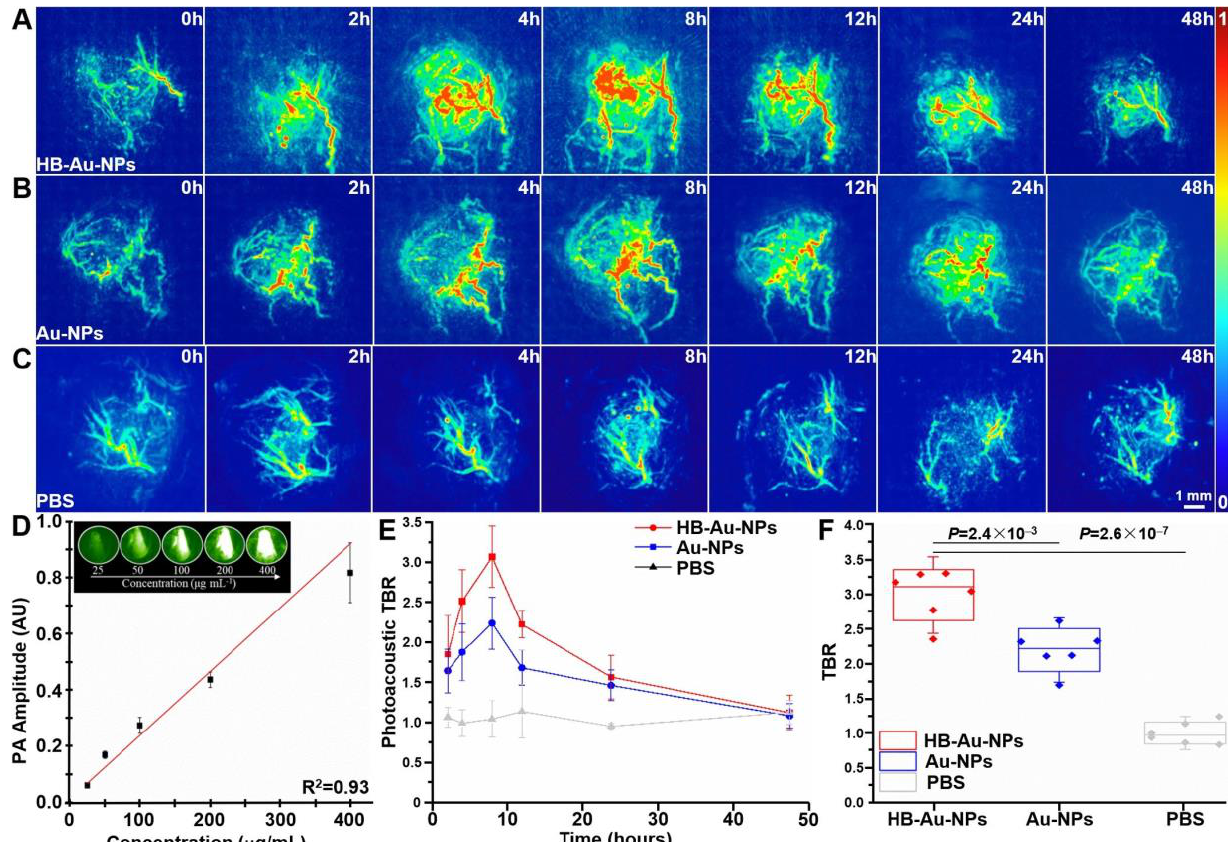
Figure 4. Photoacoustic tomography. In vivo images of human xenograft tumors implanted in mice are shown between 0–48 h post-injection of ( A ) HB-Au-NPs, ( B ) Au-NPs, and ( C ) PBS. ( D ) The in vitro photoacoustic intensity increases linearly with concentration of HB-Au-NPs, R 2 = 0.93. Inset: photoacoustic images are shown of HB-Au-NPs in vials at different concentrations (25, 50, 100, 200, and 400 µ g/mL). ( E ) Quantified intensities from the tumors show a peak T/B ratio of 3.08 ± 0.37 and 2.27 ± 0.31 at 8 h post-injection for HB-Au-NPs and Au-NPs, respectively. ( F ) The mean value for HB-Au-NPs is significantly greater than that for either Au-NPs or PBS in n = 6 animals, p = 2.4 × 10 − 3 and 2.6 × 10 − 7 , respectively, by unpaired